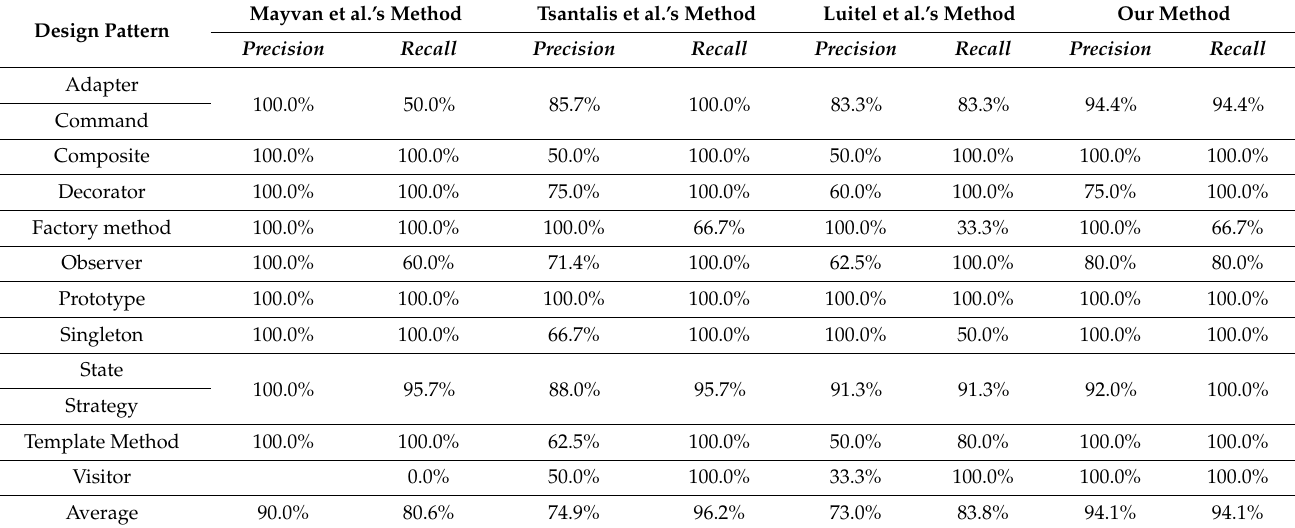
Table 5. The precisions and recalls in JHotDraw 5.1.